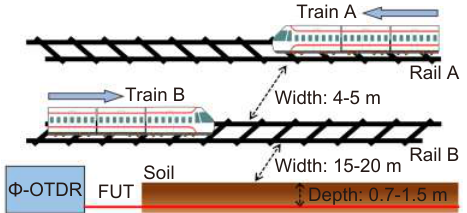
Fig. 10 | Fiber cable layout alongside railways. Figure redrawn after ref. 113